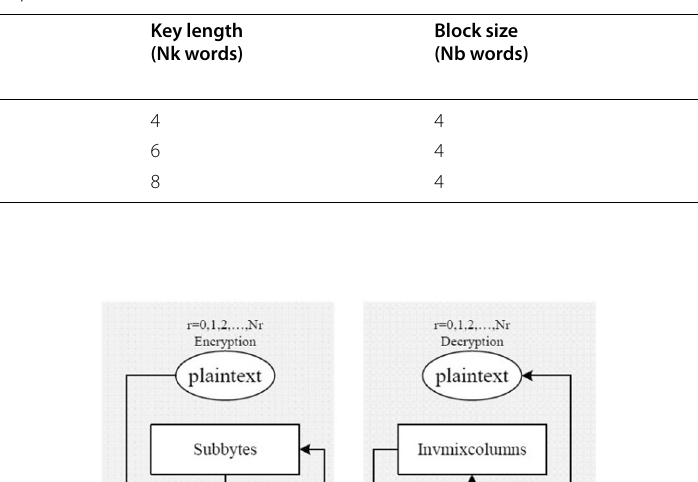
Table 1 AES parameters [2]